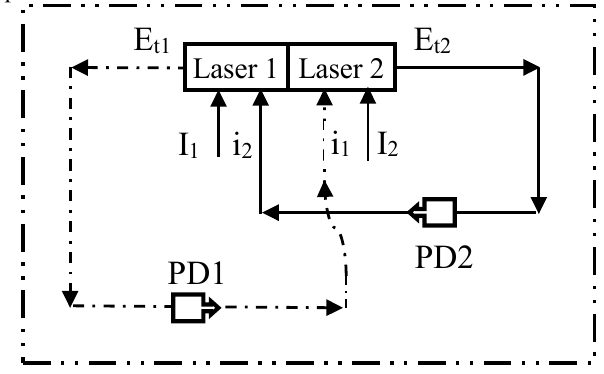
Fig. 1 . OD-DCF chaos-control block. I is the current. i is the photocurrent. E is the light field. PD is the